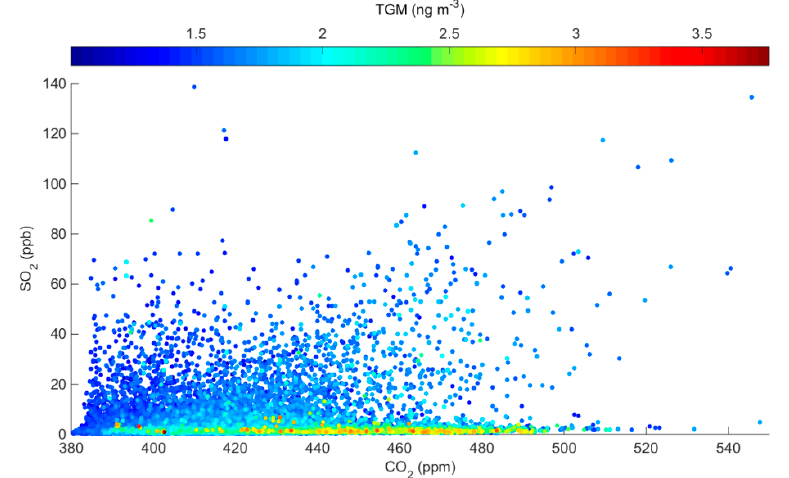
Figure 6. Observed SO 2 versus CO 2 at the monitoring site, color-coded by corresponding TGM measurements.